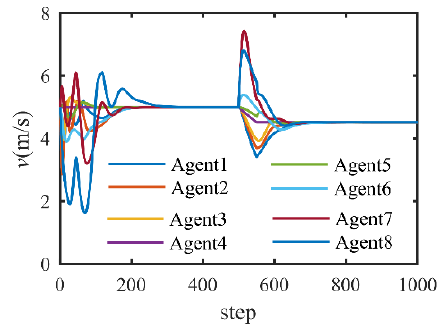
Figure 6. Velocity control with the proposed controller.